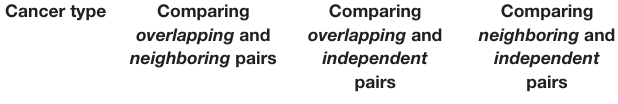
TABLE 5 | Summary of regression analysis on RBP-microRNA pairs. Comparing overlapping